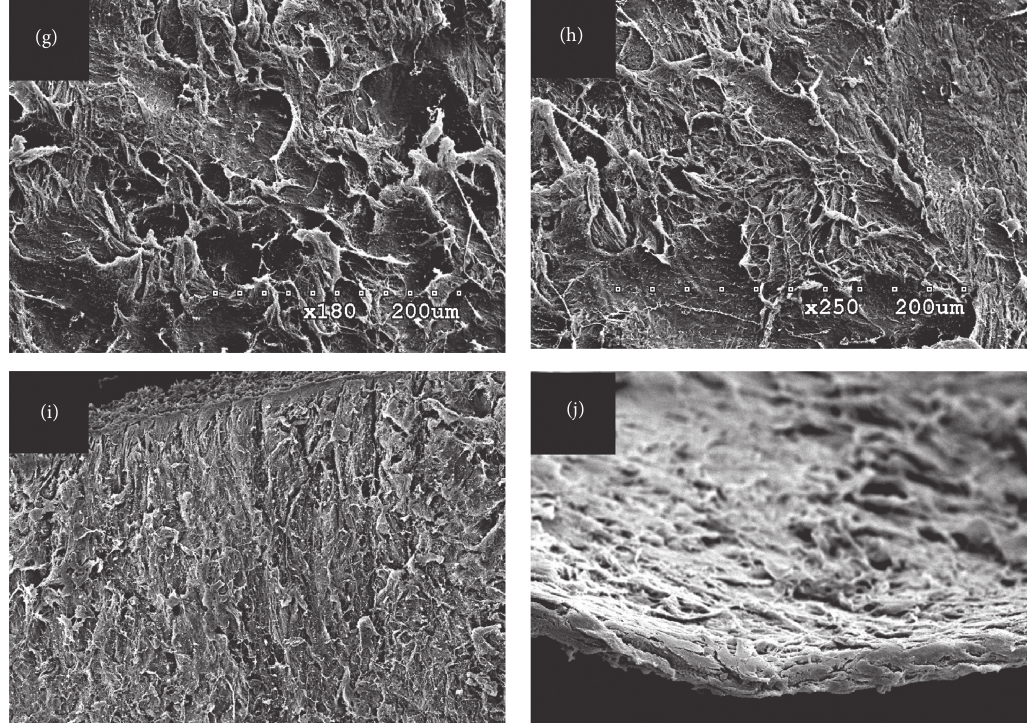
Figure 2: Scanning electron microscopy images of the lenticule surfaces and edges. (a), (b) Anterior surfaces of the lenticules created by Femto LDV Z8 at × 180 and × 250 magnifications, respectively; (c), (d) posterior surfaces of the lenticules created by Femto LDV Z8 at × 180 and × 250 magnifications, respectively; (e), (f) anterior surfaces of the lenticules created by VisuMax at × 180 and × 250 magnifications, respectively; (g), (h) posterior surfaces of the lenticules created by VisuMax at × 180 and × 250 magnifications, respectively; (i), (j) the lenticule edges created by Femto LDV Z8 and VisuMax at × 180 magnifications,